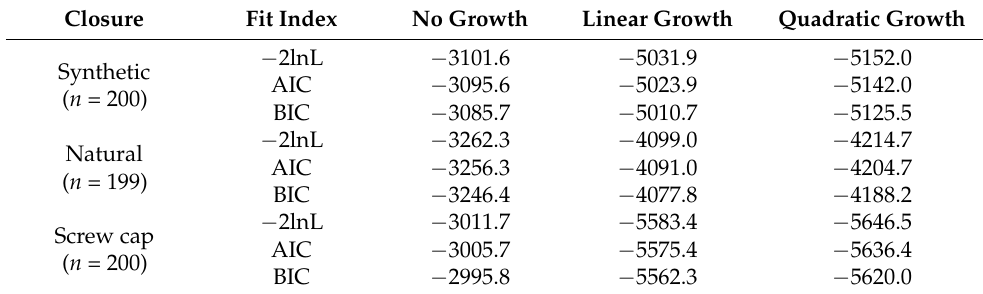
Table 2. Maximum likelihood estimates (MLE) of the growth model parameters by closure .